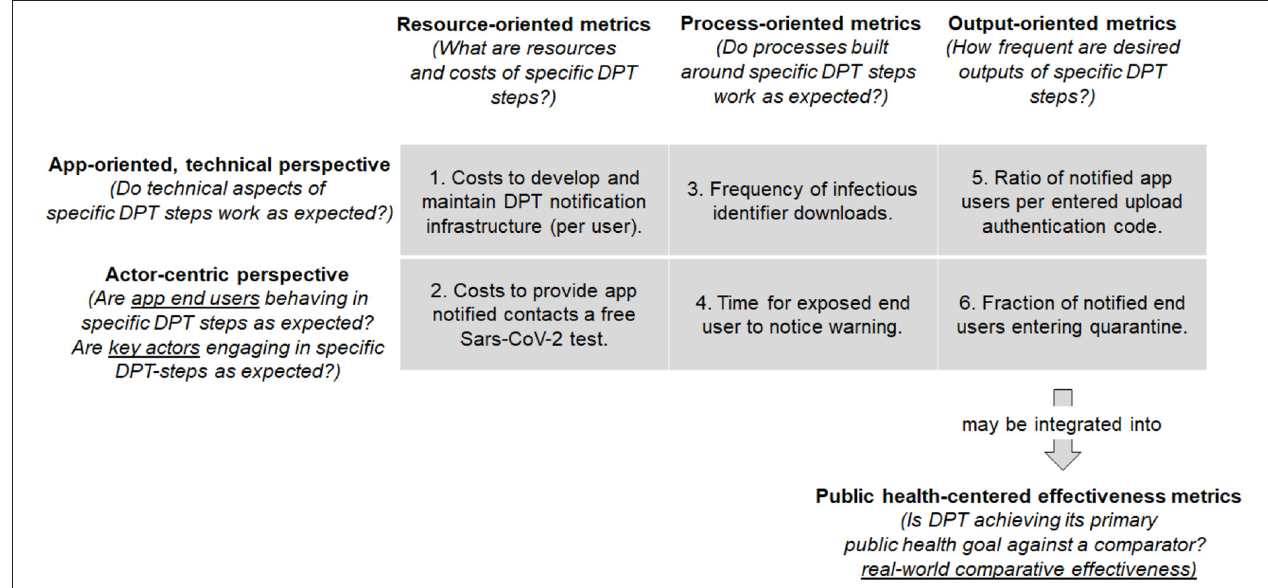
FIGURE 3 | Proposal for classification matrix of different indicator types to monitor DPT systems by steps of the Input-Process-Output model (resource-, process-, and output metrics) as well as by aspect (app-oriented, technical viewpoint vs. actor-centric perspectives). The examples in the matrix pertain to the notification step of proximity contacts (section Notification of Proximity Contacts ). The output oriented metrics (5 & 6) may be integrated into public health-centered